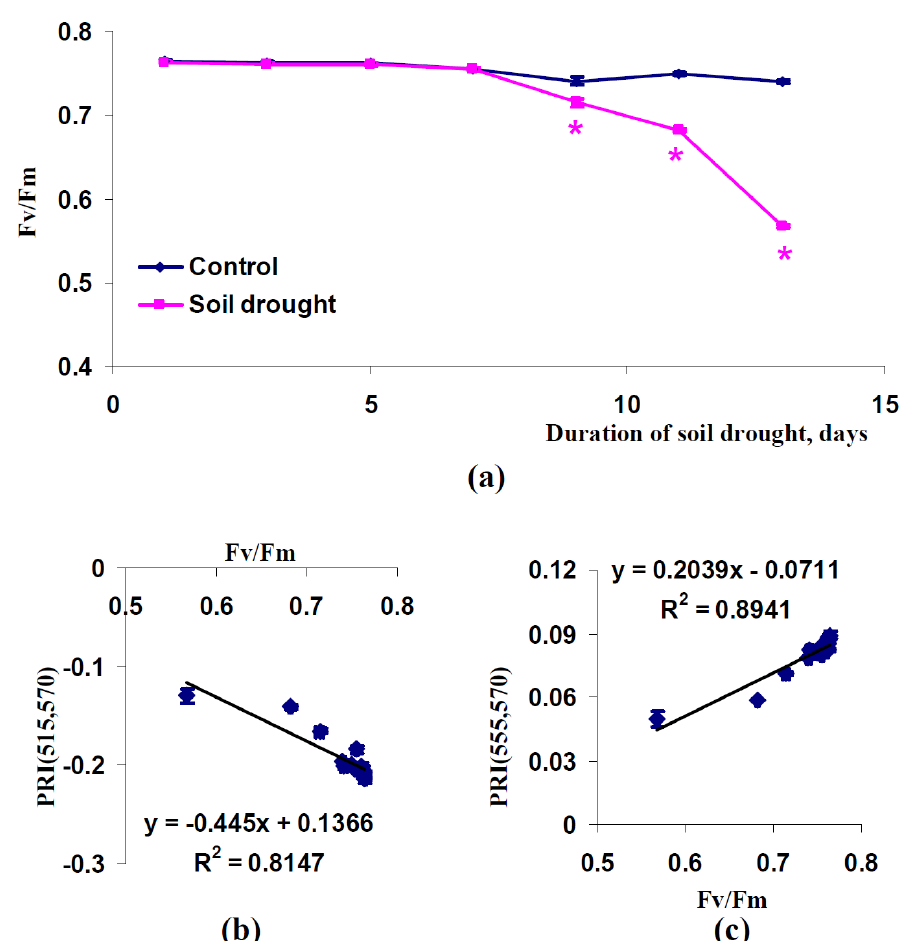
Figure 10. Dependence of Fv/Fm in leaves of pea plants cultivated under conditions of a vegetation room on the duration of the soil drought ( n = 45) ( a ) and dependences of average values of PRI(515,570) ( b ) and PRI(555,570) ( c ) in the canopy on Fv/Fm ( n = 14). Average values of PRI(515,570) and PRI(555,570) from Figure 7 were used. R 2 is the determination coefficient. *, difference between experimental and control indices was significant ( p < 0.05).